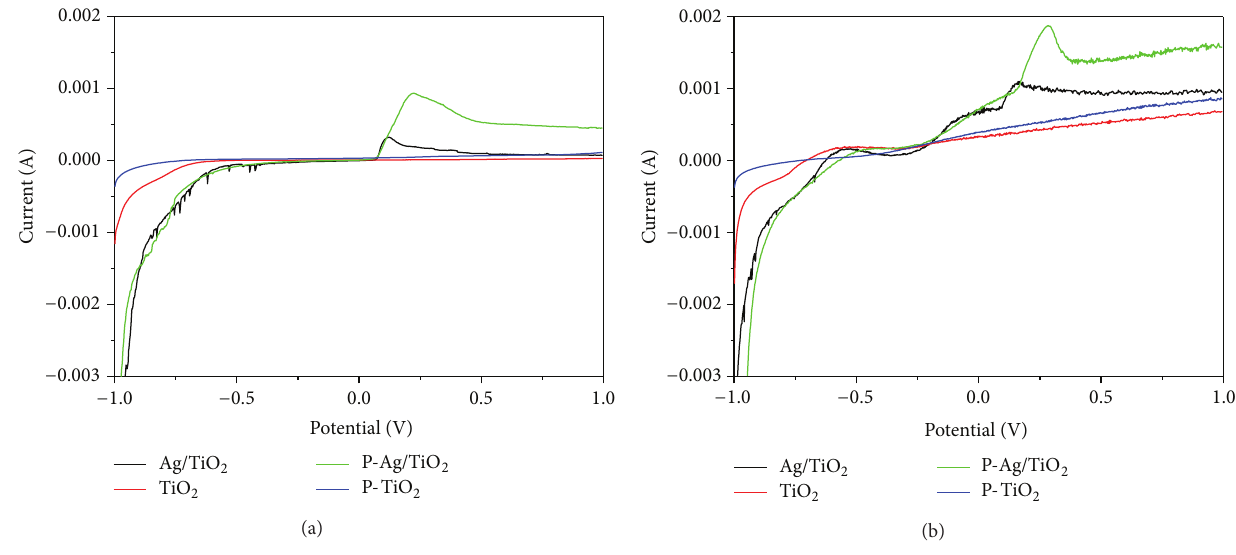
Figure 6: LSV voltammograms of TiO 2 , Ag/TiO 2 , P-TiO 2 , and P-Ag/TiO 2 in (a) dark and (b) solar light, at a scan rate of 0.1V/s.